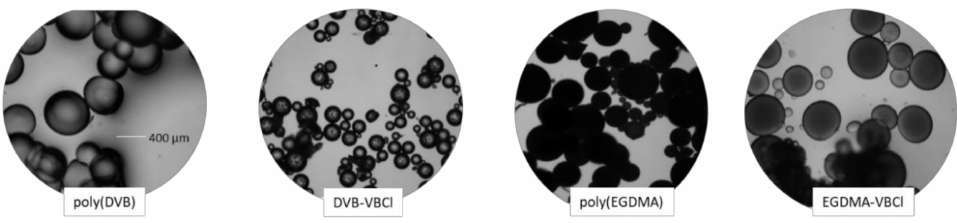
Figure 3. Photos of the synthetized